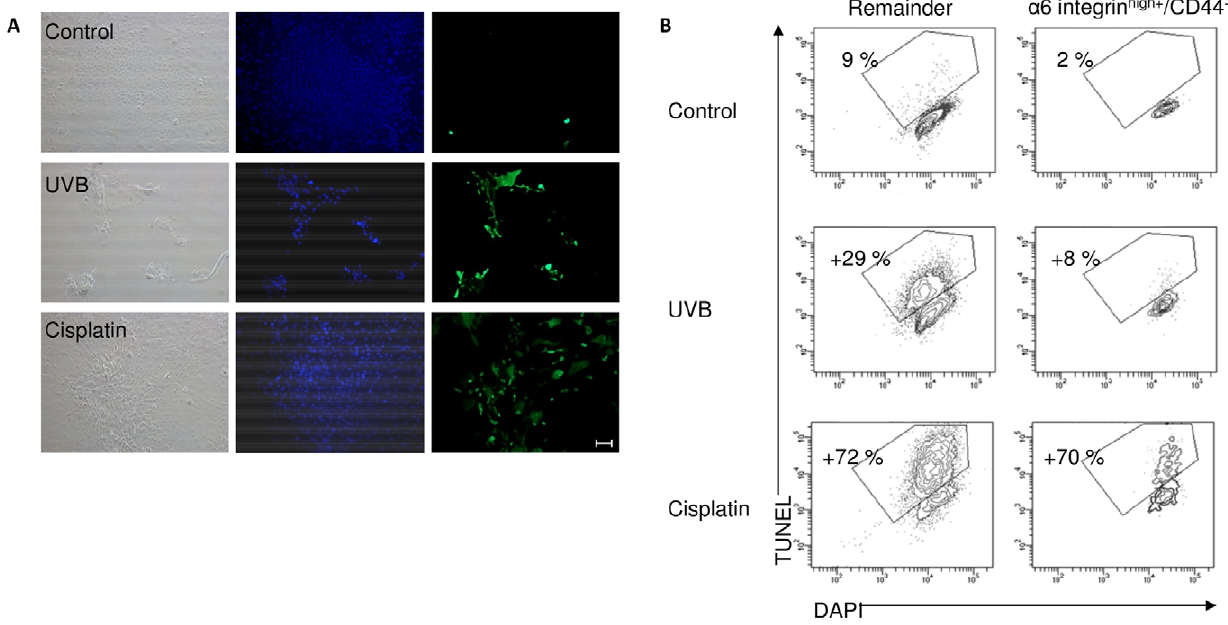
Figure 4. Apoptosis detection using Active Caspase-3 and TUNEL. (A) Keratinocytes were grown for 5 days to form colonies, treated with UVB (20 mJ/cm 2 ) or cisplatin (200 m g/ml) or vehicle-only (control). After 24 hr the cells were stained with an antibody against Active Caspase-3 and photographed. Nuclei are stained blue with DAPI. (B) Keratinocytes were grown for 5 days, treated with UVB (30 mJ/cm 2 ), cisplatin (50 m g/ml) or vehicle-only (control) for 24 hours, then fixed and analysed for TUNEL + cells using flow cytometry. Data represents the mean where n=3.